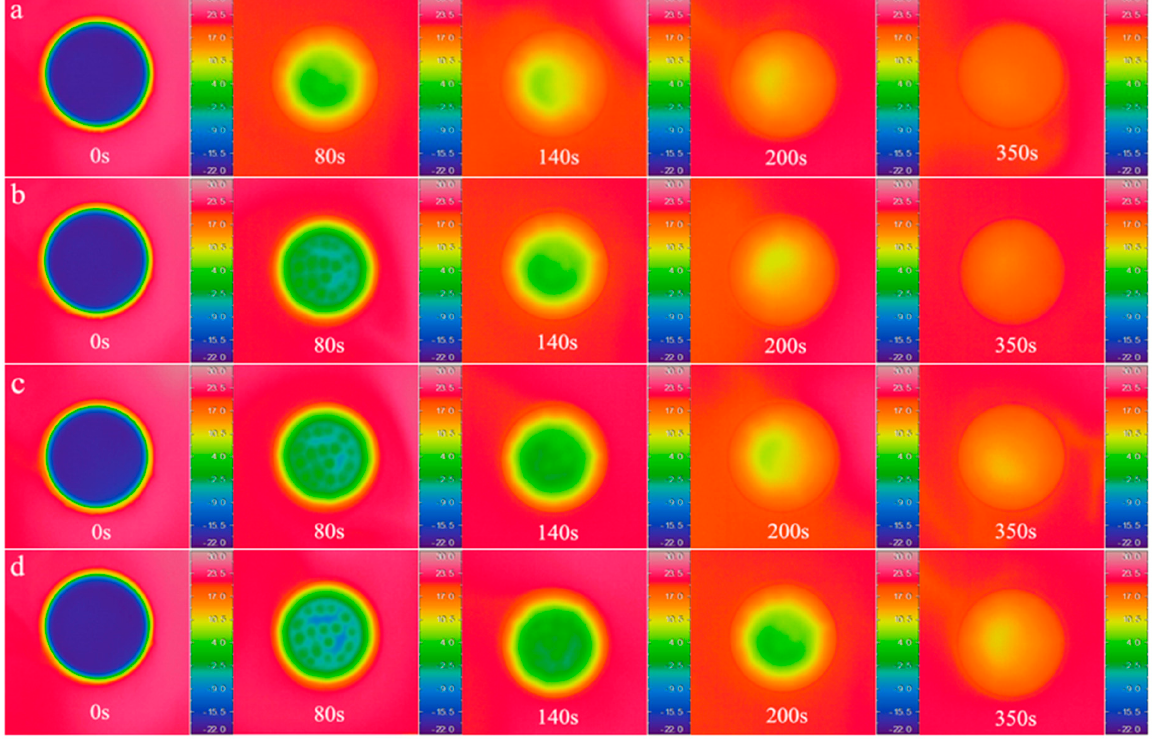
( b ) Figure 12. Temperature of antifreeze fluid and different mass concentrations of MPCS under ( a ) heating and ( b ) cooling process.